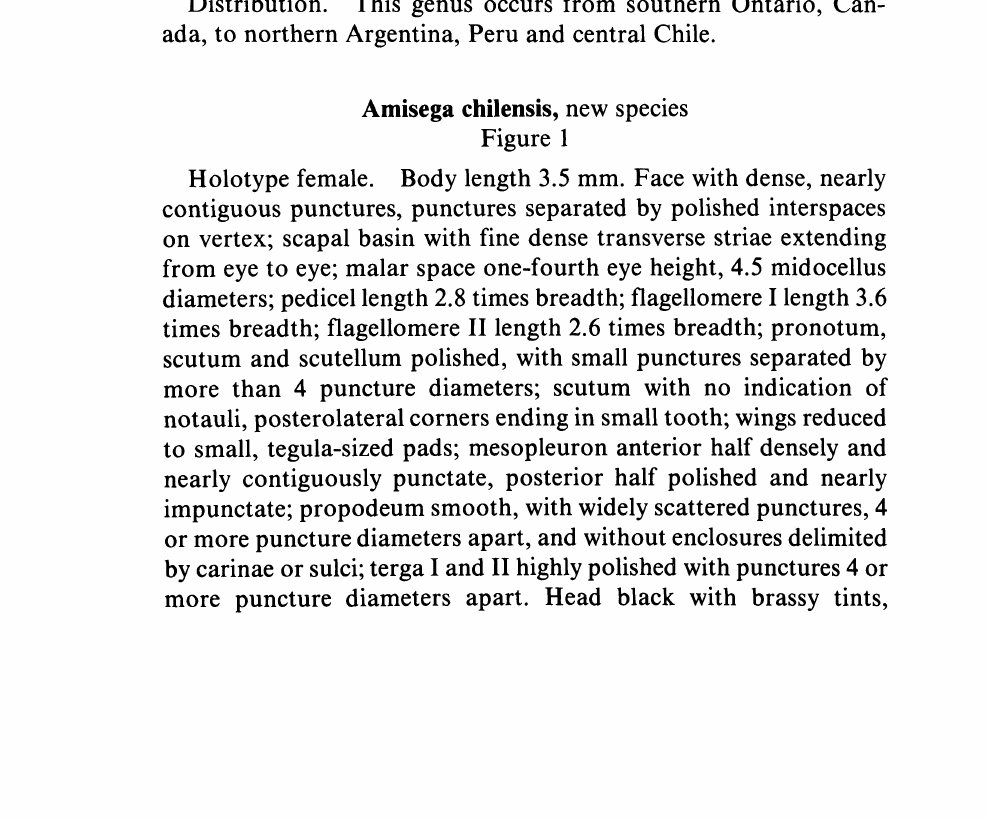
H olotype female. Body length 3.5 mm. Face with dense,